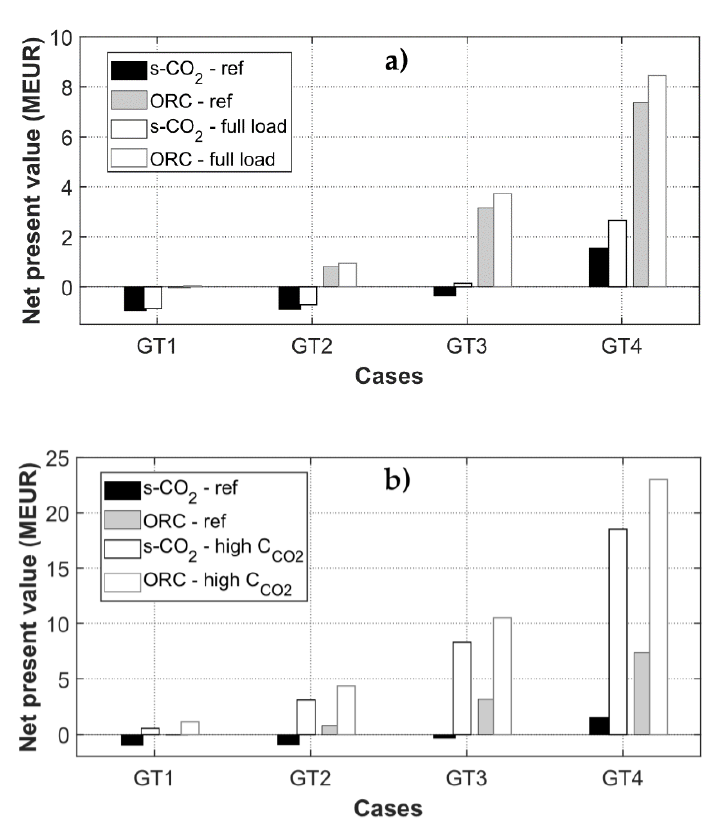
Figure 13. Net present value comparison between the reference case study and: ( a ) a full load yearly operation and ( b ) the application of a higher carbon tax.